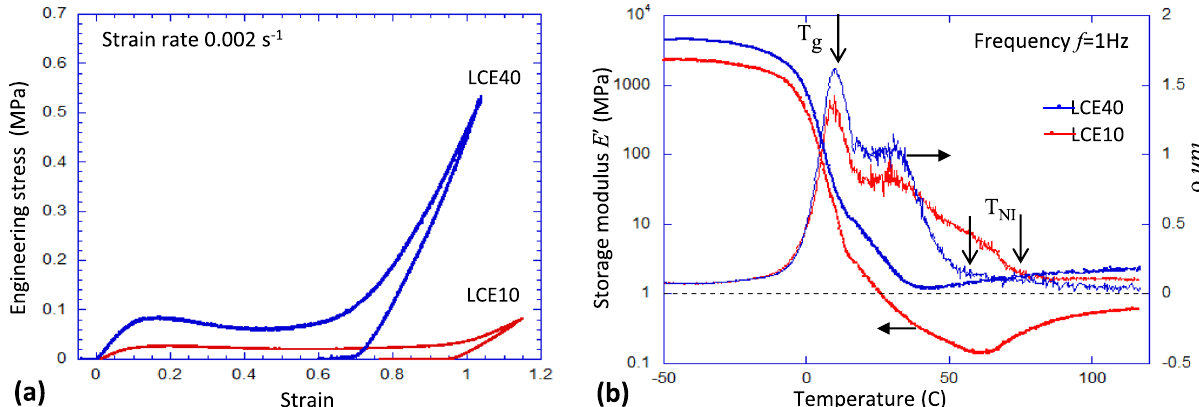
Fig. 1 Mechanical characterisation of LCE materials. a Near-equilibrium stress – strain curves for LCE10 and LCE40 materials, highlighting the wide soft plateau through internal re-orientation of the polydomain LCE on stretching, as well as the ability to withstand large deformations. b Temperature scan of linear oscillating response (at fi xed 1 Hz), highlighting the high tan δ across all of the nematic range.